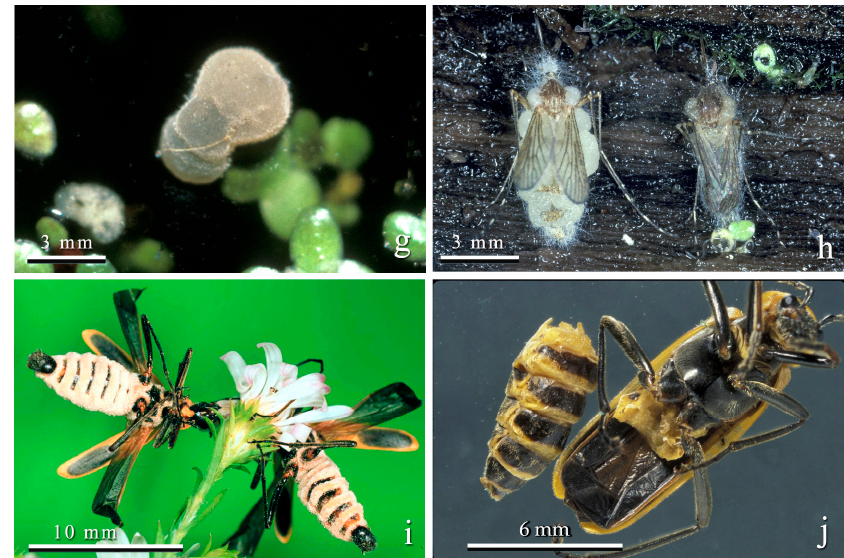
Figure 5. Insect-pathogenic entomophthoralean fungi. ( a ) Male Magicicada septendecim showing abdomen full of resting spores of Massospora cicadina. ( b ) M. septendecim showing abdominal hole through which M. cicadina resting spores are scattered as the living infected cicada flies. ( c ) Cotton aphid, Aphis gossypii , infected with the conidial stage of Neozygites fresenii held onto the leaf by mouthpart stylets. Primary conidia are explosively discharged into the air, onto the leaf, and onto